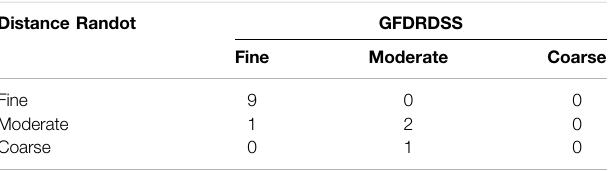
TABLE 5 | The results of 13 stereotest from 12 subjects examined by Distance Randot (3 m) and GFDRDSS (5 m). Distance